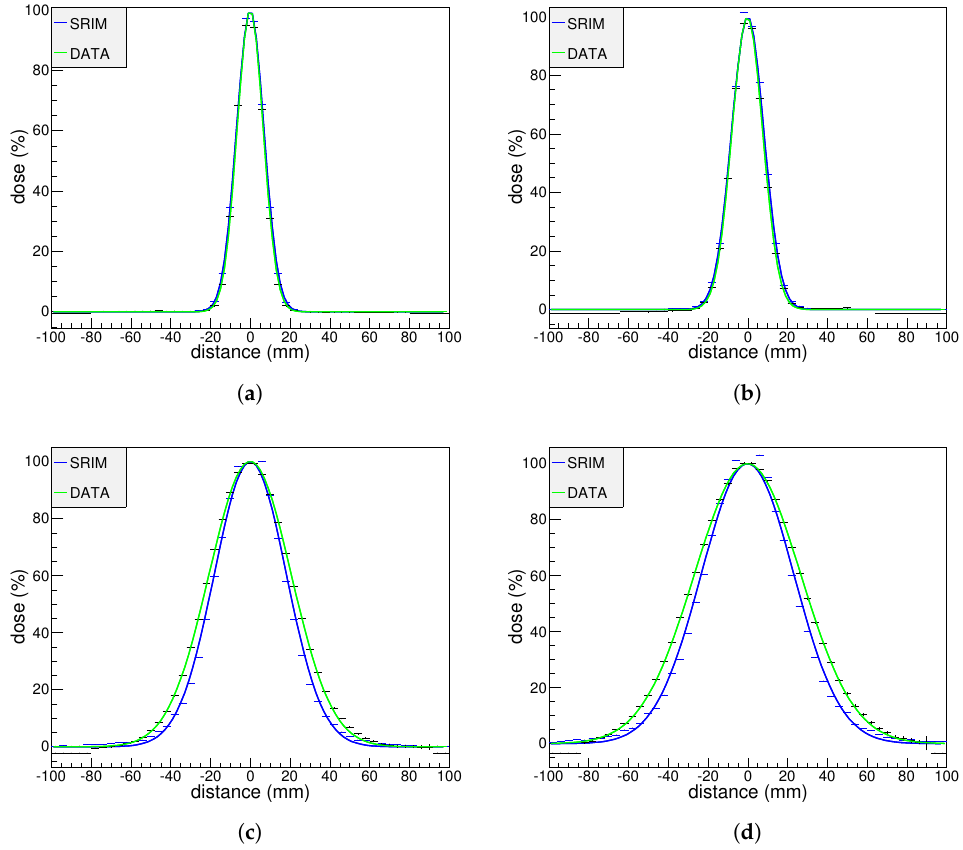
Figure 7. Lateral dose profiles measured (green) and simulated (blue) at different irradiation conditions; the energy value stands for the mean energy at the active volume of the EBT3 film. ( a ) 15.6MeV: FWHM SRIM = 16.3mm and FWHM DATA = 15.5mm. ( b ) 15.1MeV: FWHM SRIM = 19.3mm and FWHM DATA = 18.3mm. ( c ) 14.2MeV: FWHM SRIM = 42.6mm and FWHM DATA = 48.5mm. ( d ) 13.7MeV: FWHM SRIM = 54.6mm and FWHM DATA =